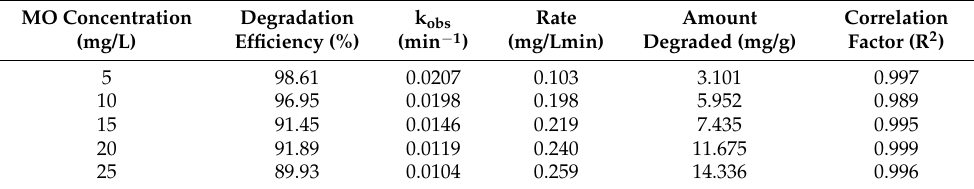
Figure 9. The effect of initial concentration on ( a ) degradation efficiency and ( b ) kinetics of MO degradation in the P-AgC (13%) film photocatalyst (volume of MO: 0.3 L, number of films: 2 films). Table 3. Kinetic data and amount of MO degraded at different initial concentrations using P-AgC.